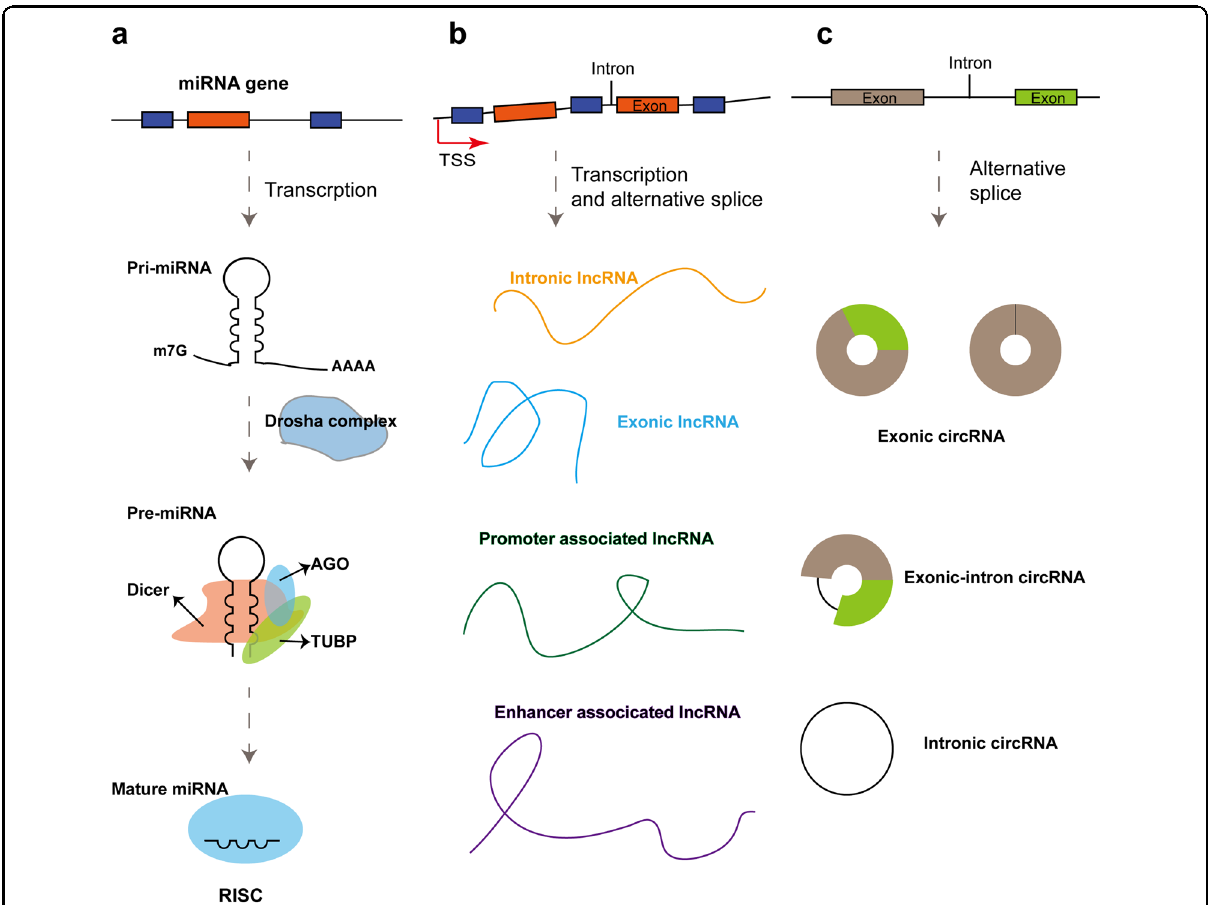
Fig. 1 Biogenesis of several noncoding RNAs. a Transcription of miRNAs is regulated by RNA polymerase II. The pri-miRNAs are processed by several consecutive cleavages to produce mature miRNAs since the pri-miRNAs are transcripted. Finally, mature miRNAs are incorporated into the Argonaute to form miRNA-induced silencing complex (RISC). b According to the different origin transcription sites, lncRNAs can be divided into various types: intronic lncRNAs, exonic lncRNAs, promoter-associated lncRNAs, and enhancer-associated lncRNAs. c Most circRNAs are derived from the pre-mRNA. Due to the different compositions, circRNAs are classi fi ed into several types, including exonic circRNAs, exonic-intronic circRNAs, and intronic